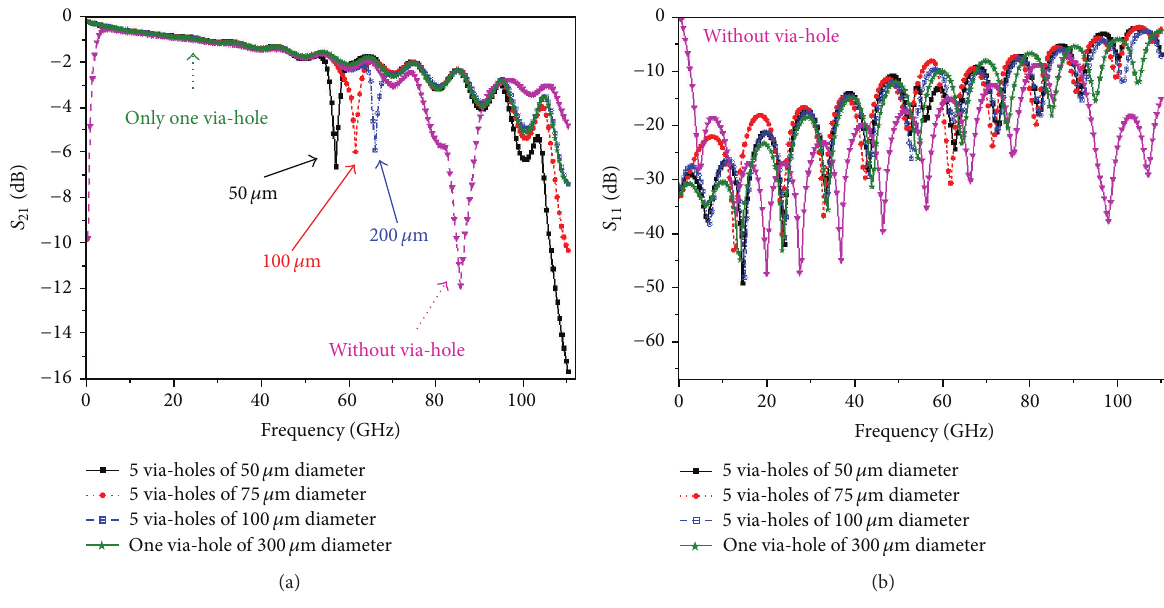
Figure 4: 𝑆 -parameters of the back-to-back transitions without and with one optimized via-hole ( 𝑑 = 300 𝜇 m located 500 𝜇 m from both axes I and II; cf. Figure 3) and with five via-holes of different diameters (50 𝜇 m, 75 𝜇 m, and 100 𝜇 m) spaced by 250 𝜇 m along 𝑥 - and 𝑧 - directions (cf. Figure 3). (a) Transmission coefficient 𝑆 21 (dB) and (b) reflection coefficient 𝑆 11 (dB).